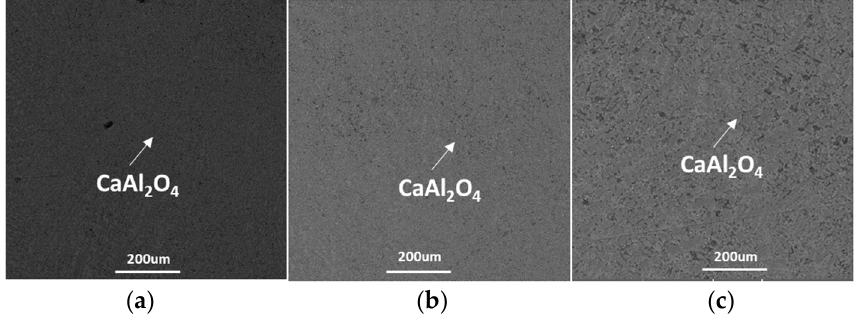
Figure 12. SEM micrographs of the CaO–Al 2 O 3 -based mold flux after CSLM measurements: ( a ) 100 °C·min − 1 , ( b ) 300 °C·min − 1 , and ( c ) 500 °C·min − 1 .